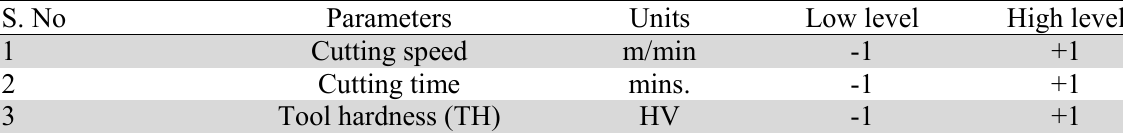
Assignment of the factor levels